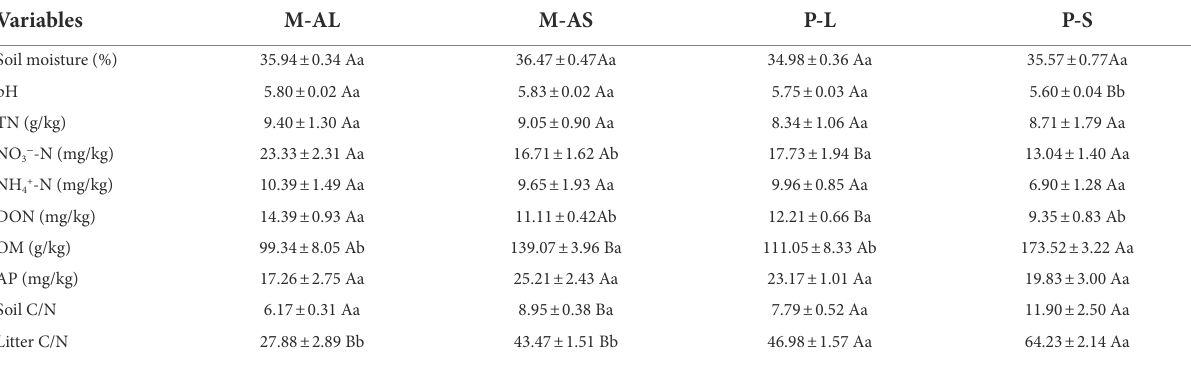
TABLE 3 Soil physicochemical properties and litter quality of Larch monoculture, Spruce monoculture, Ash-Larch mixture and Ash-Spruce mixture stands at Maoershan Experiment Station, Northeast China. Variables